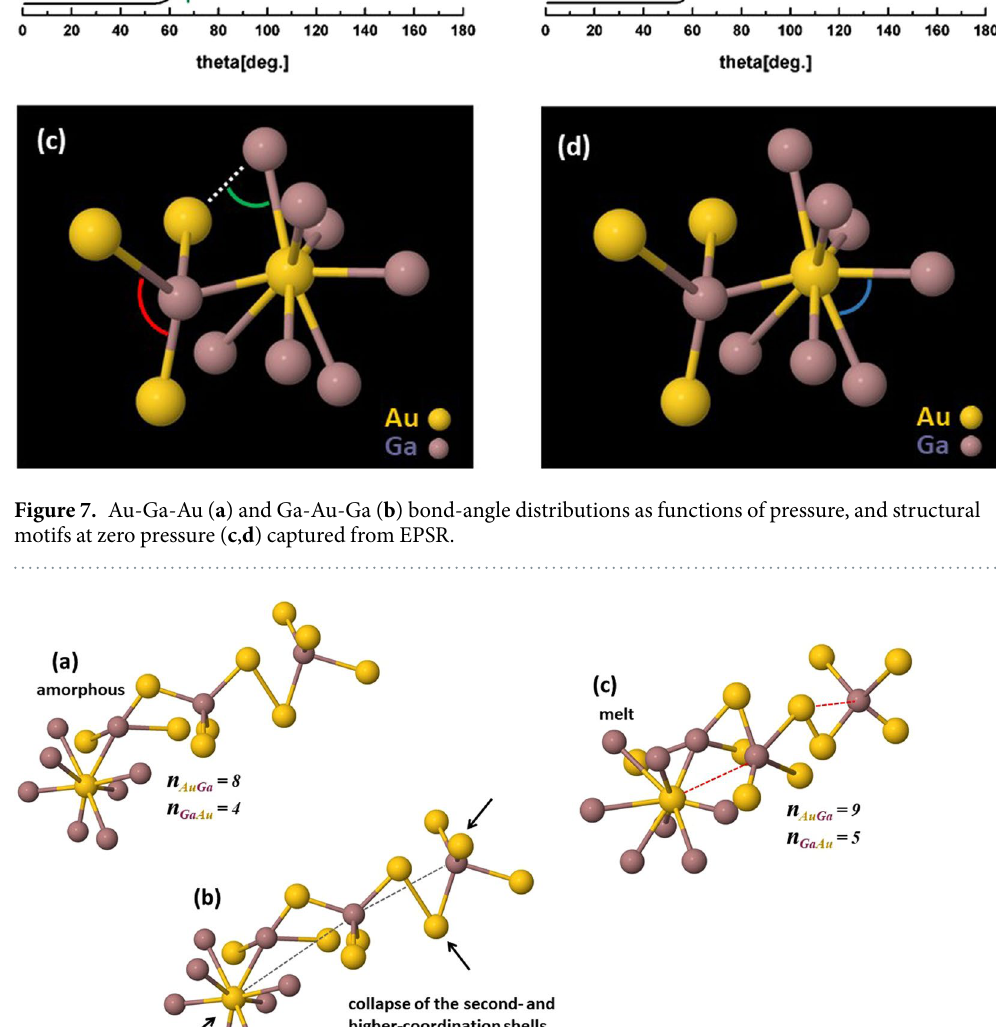
used to obtain the structure factor from the diffraction data 36 . The EPSR simulations show good agreement with zero-pressure diffraction data for amorphous AuGa 2 (Supplementary Figure S8). Our fits to experimental S ( Q ) yield chi-square values in the range χ 2 = 0.002–0.016 (Supplementary Figure S9), with convergence in ~2600 iterations and best fits achieved after ~8000 iterations of the EPSR steps